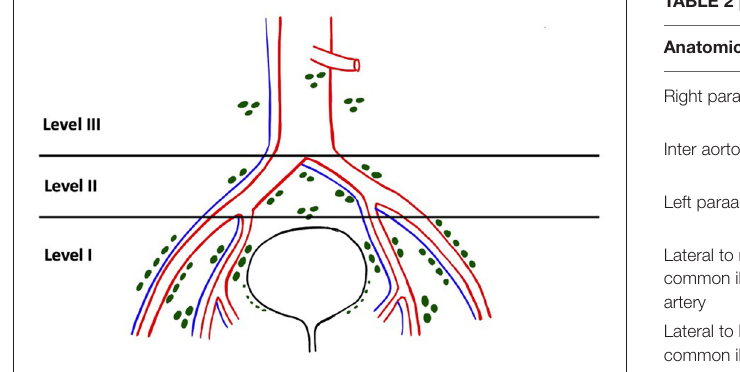
FIGURE 3 | Levels of lymph node dissection during radical cystectomy as described by Leissner et al.